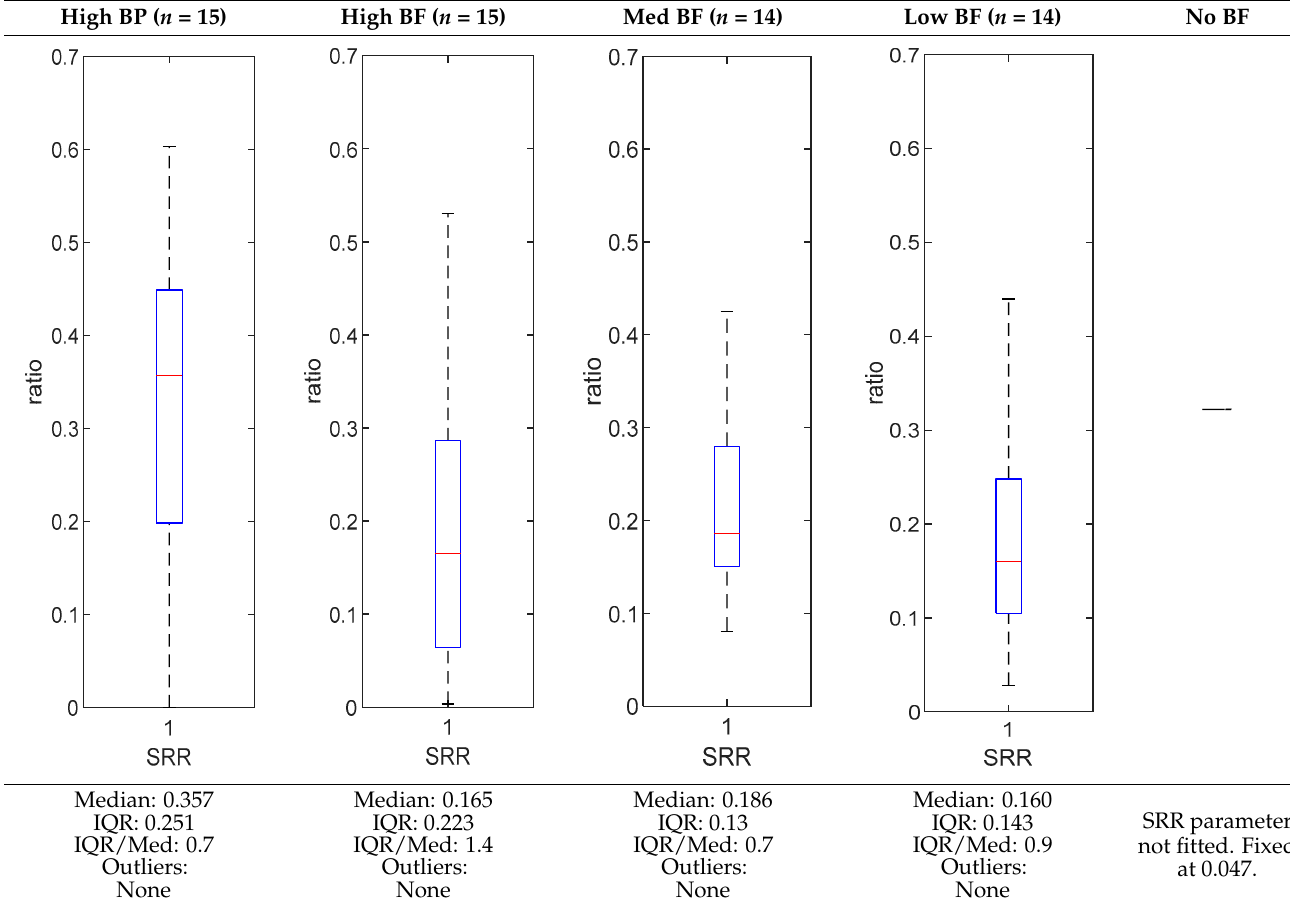
Table 4. SRR estimation results (horizontal red bar: median, blue box second and third quartile, whiskers first and fourth quartiles).